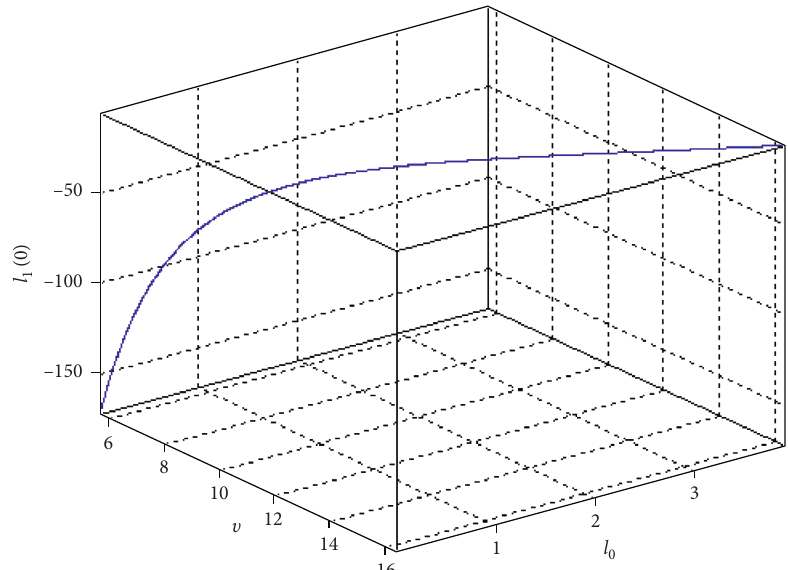
Figure 4: For the system of Figure 2, the values of the first Lyapunov’s coefficient l